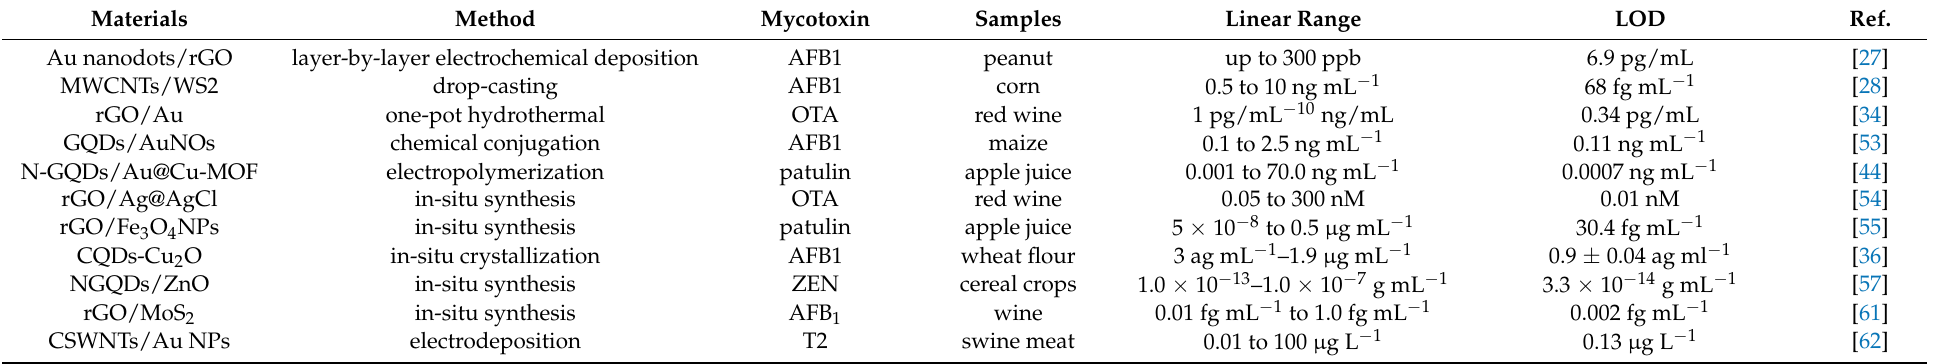
Table 1. Carbon nanomaterial composites for mycotoxin detection.